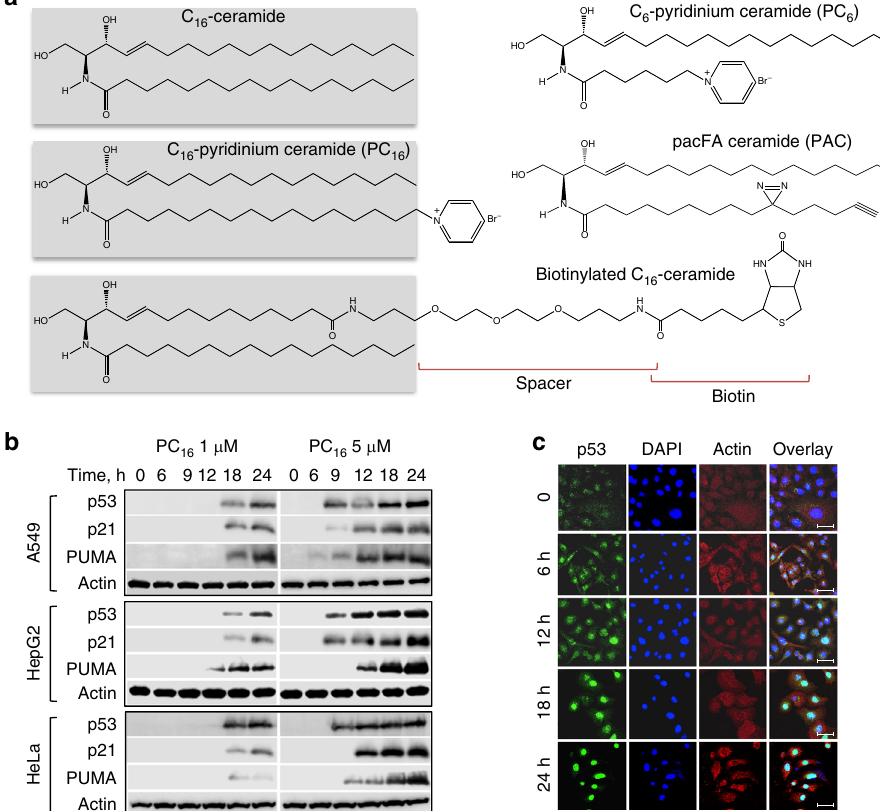
Fig. 1 C 16 -pyridinium ceramide activates p53. a Structures of ceramide compounds used in this study (the C 16 -ceramide component is shown in gray box). b Treatment of cancer cells with C 16 -pyridinium ceramide elevates p53 and its downstream targets in a concentration-dependent manner (western blot analysis). c p53 rapidly accumulates in the nuclei of A549 cells upon C 16 -pyridinium ceramide treatment (confocal images, scale bar represents 40 μ